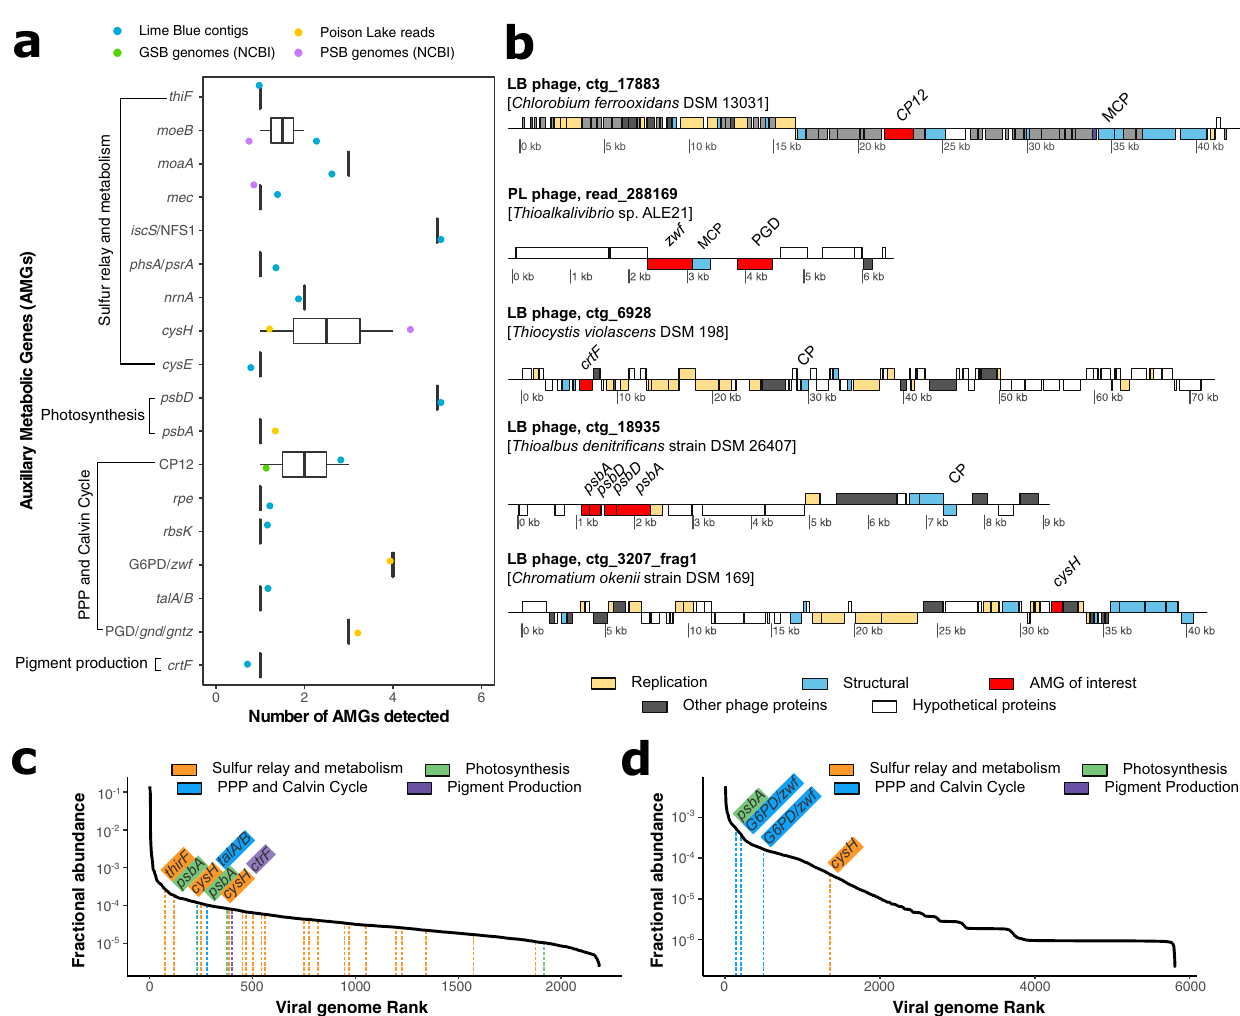
Fig. 3 Distribution of phage auxiliary metabolic genes (AMGs). a AMG abundances (median and standard deviation) and ( b ) genome maps of putative phages containing AMGs of interest. AMGs were identi fi ed by VIBRANT except for CP12, which was identi fi ed by BLASTp of phage ORFs to a database of available CP12 proteins from UniProt. Putative hosts identi fi ed based on CRISPR spacers are indicated for each phage. Viral rank-abundance curves for ( c ) Lime Blue and ( d ) Poison Lake. Each putative phage genome identi fi ed represents a point on the rank abundance curve and phages encoding AMGs of interest are annotated with the dotted lines. (LB Lime Blue, PL Poison Lake, MCP major capsid protein, CP putative capsid protein, PGD 6-phosphogluconate dehydrogenase [ zwf